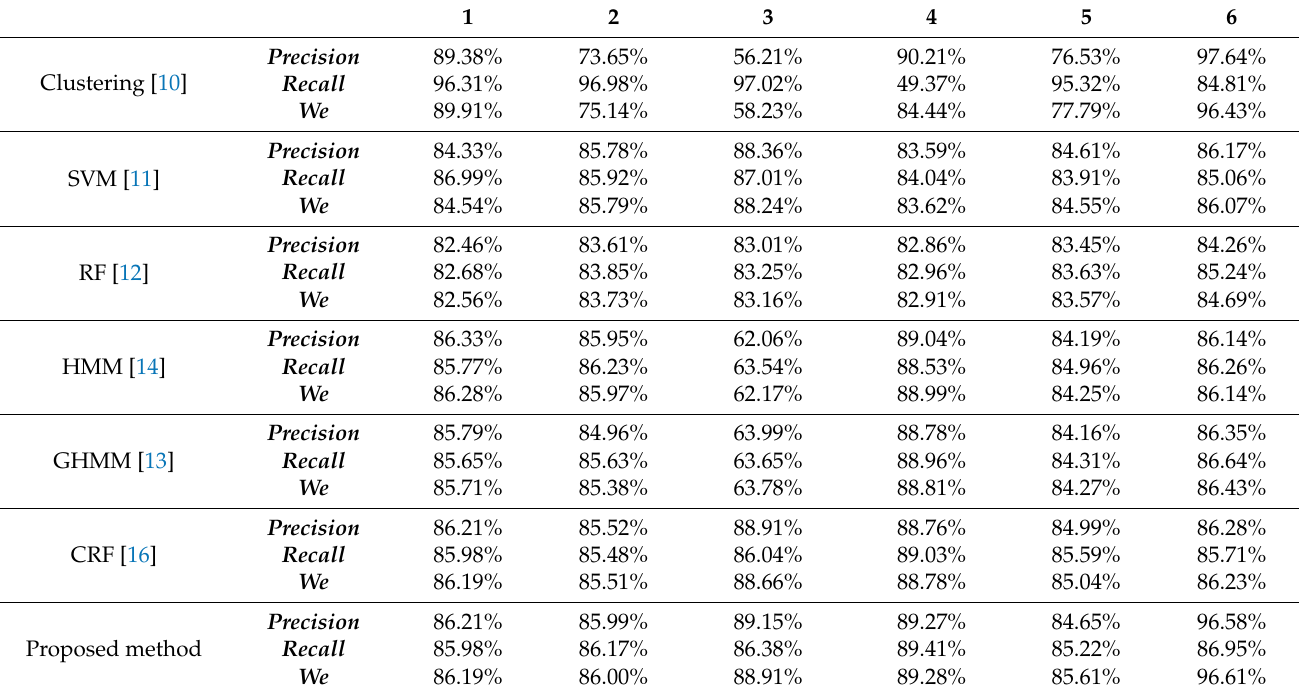
Table 5. Comparison of sample gaze test evaluation